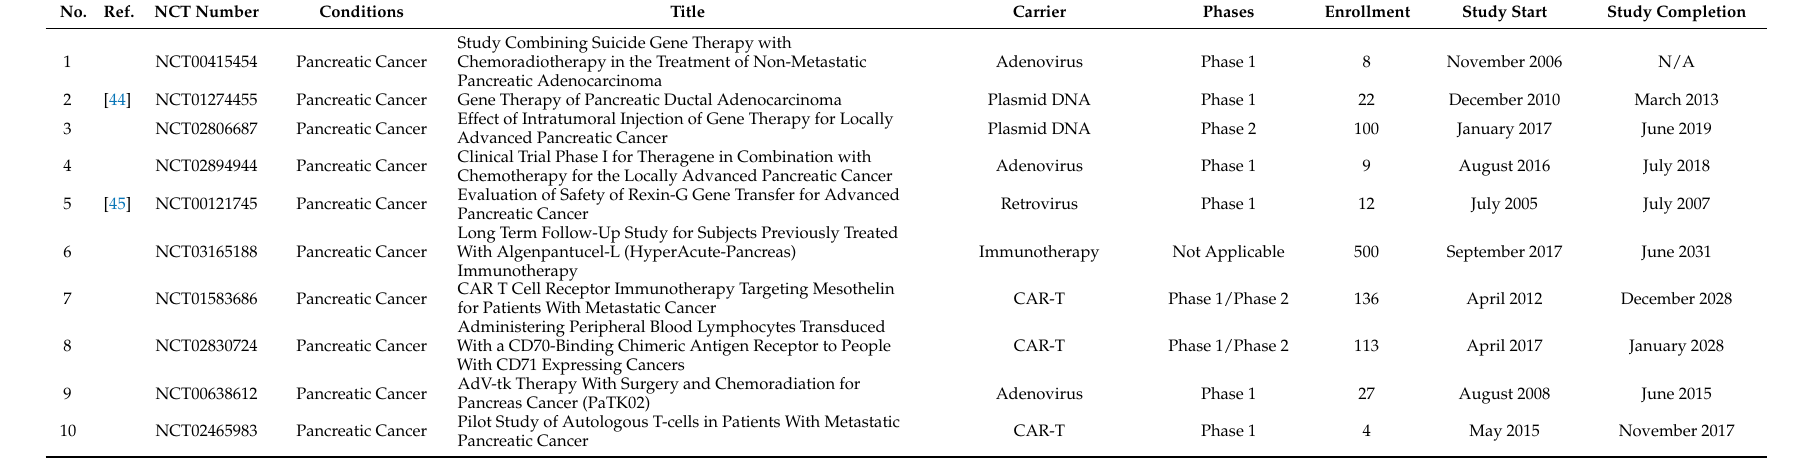
Table 2. Summary of clinical trials